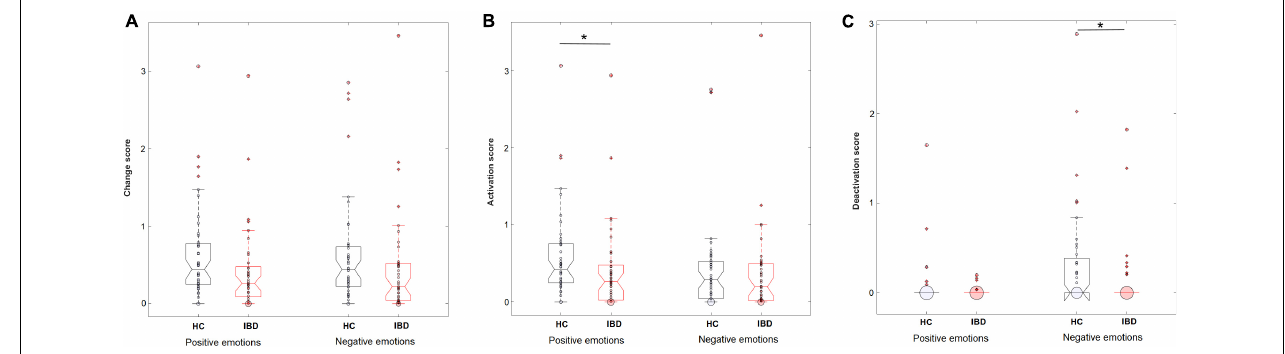
FIGURE 1 | Perceived levels of overall changes in the body (A) , sensations of activation (B) , and sensations of deactivation (C) in the body during the experience of positive and negative emotions in HC ( n = 44) and IBD ( n = 41). * p < 0.05.